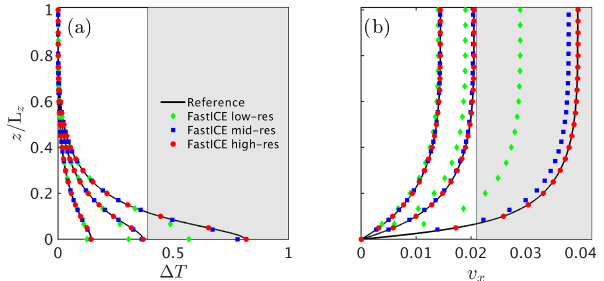
Figure 10. Non-dimensional simulation results for (a) the temper- ature deviation T and (b) the horizontal velocity component v x to test solver performance at three resolutions. The vertical resolutions are LR = 31, MR = 95 and HR = 201 grid points for low-, mid- and high-resolution runs, respectively. We compare the results for non-dimensional time 1 × 10 8 , 2 × 10 8 and 2 . 9 × 10 8 . The shaded areas correspond to the part of the solution that is above the melting temperature, since we do not account for phase transitions in this benchmark.